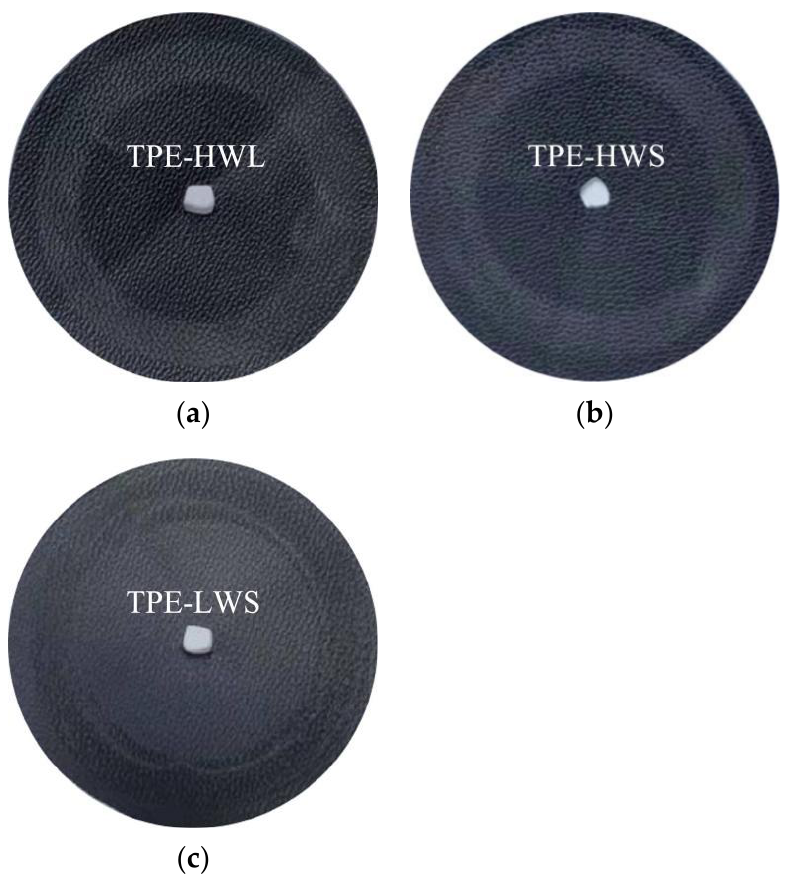
Figure 8. TPE samples prepared by SEBS with various molecular structures after Taber abrasion. ( a ) TPE-HWL; ( b ) TPE-HWS; ( c ) TPE-LWS.